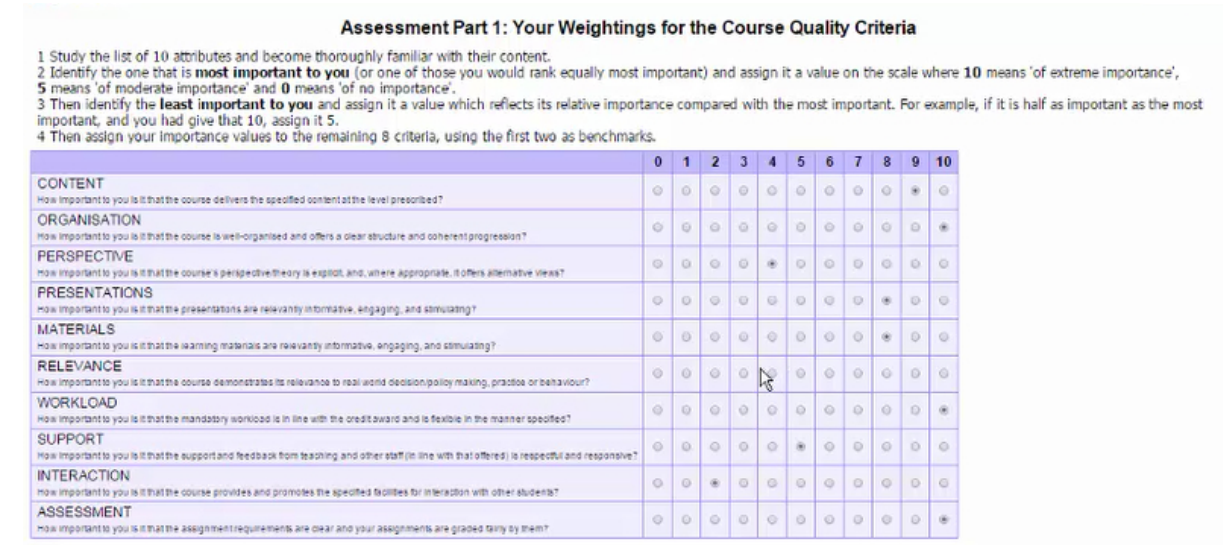
Figure 1. Screenshot from video on hypothetical student completing